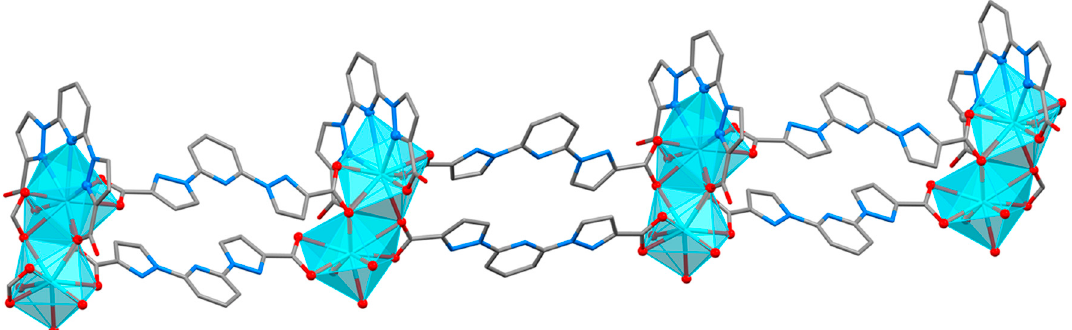
Figure 3. Chain of [M 2 L 3 (H 2 O) 3 ] n in Tb/YbL 3 .